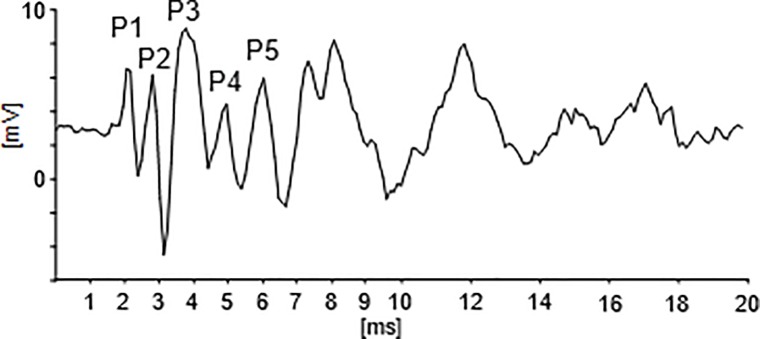
Example of an evoked-potential recording to 50 kHz tones.Only the first 20 ms after tone onset are shown. Five peaks (positive deflections, P1-P5) in the latency range of 1–6 ms define the mouse auditory brainstem response (ABR).